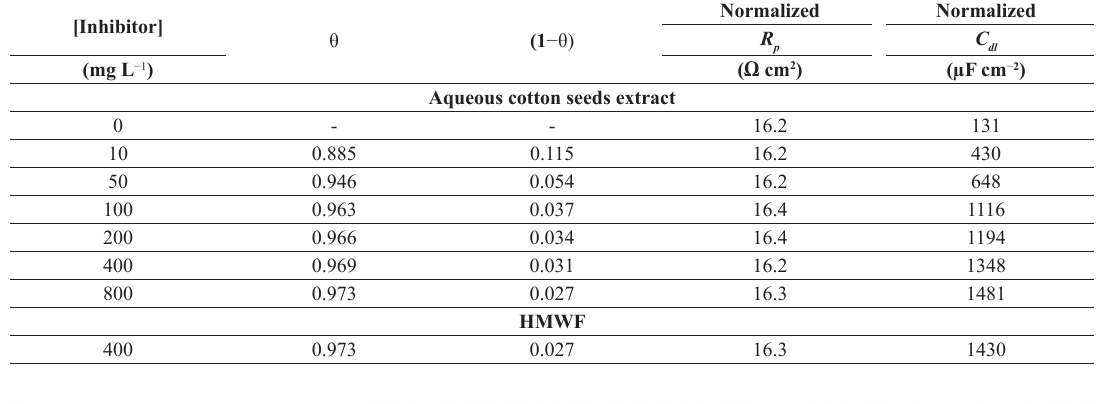
, C obtained for mild steel immersed in 1 mol L −1 HCl solution in the absence and in the presence of ACSE and Table 7. Normalized R p dl its HMWF considering the fraction of the surface covered by adsorbed molecules (θ) from the electrochemical impedance measurements.